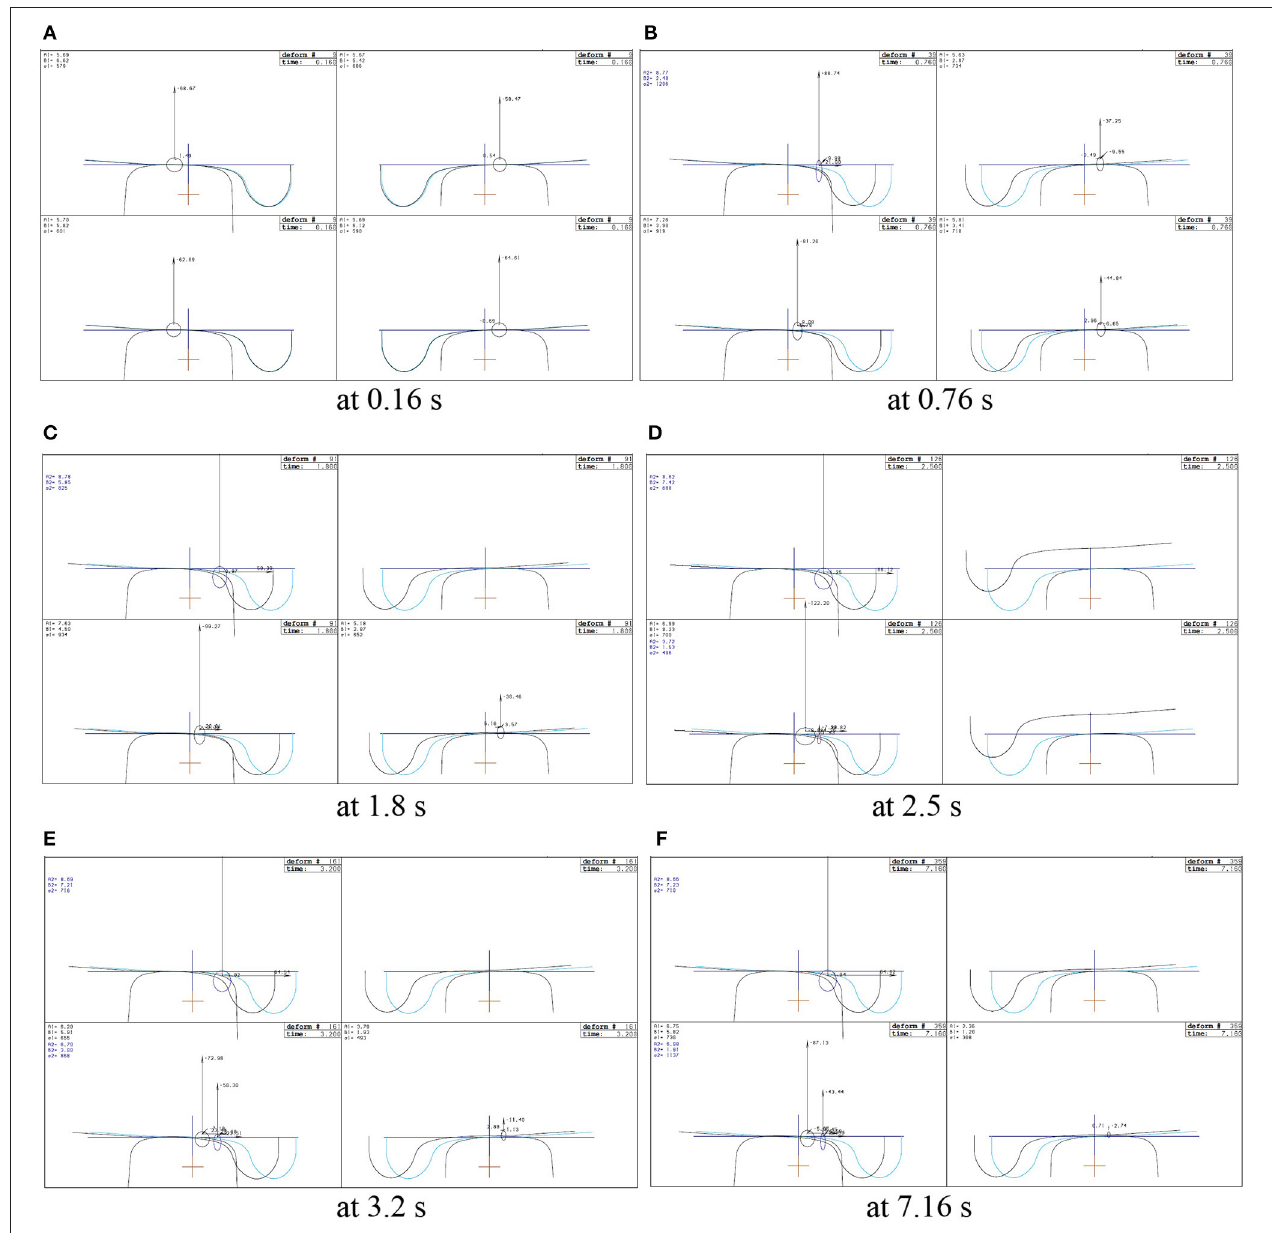
FIGURE 8 | Simulation at speed of 118km/h without guard